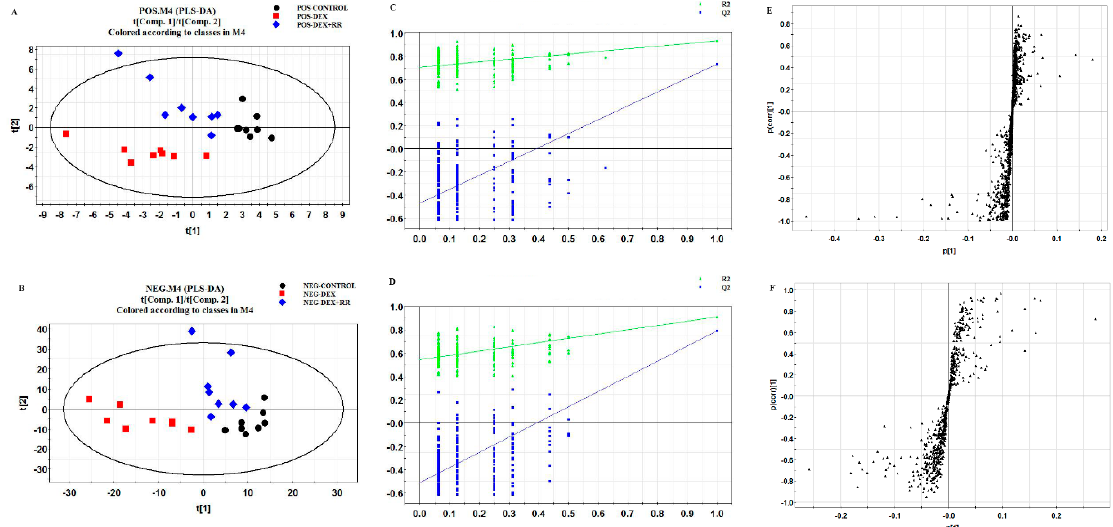
Figure 5. Multivariate analysis based on the UHPLC-Q/TOF-MS profiling data for samples in the control, DEX, and DEX+RR groups in positive and negative ion mode ( n = 8). ( A ) PLS-DA score plot in positive ion mode; ( B ) validation of PLS-DA model in positive ion mode; ( C ) S-plot of PLS-DA model in positive ion mode; ( D ) PLS-DA score plot in negative ion mode; ( E ) validation of PLS-DA model in negative ion mode; ( F ) S-plot of PLS-DA model in negative ion